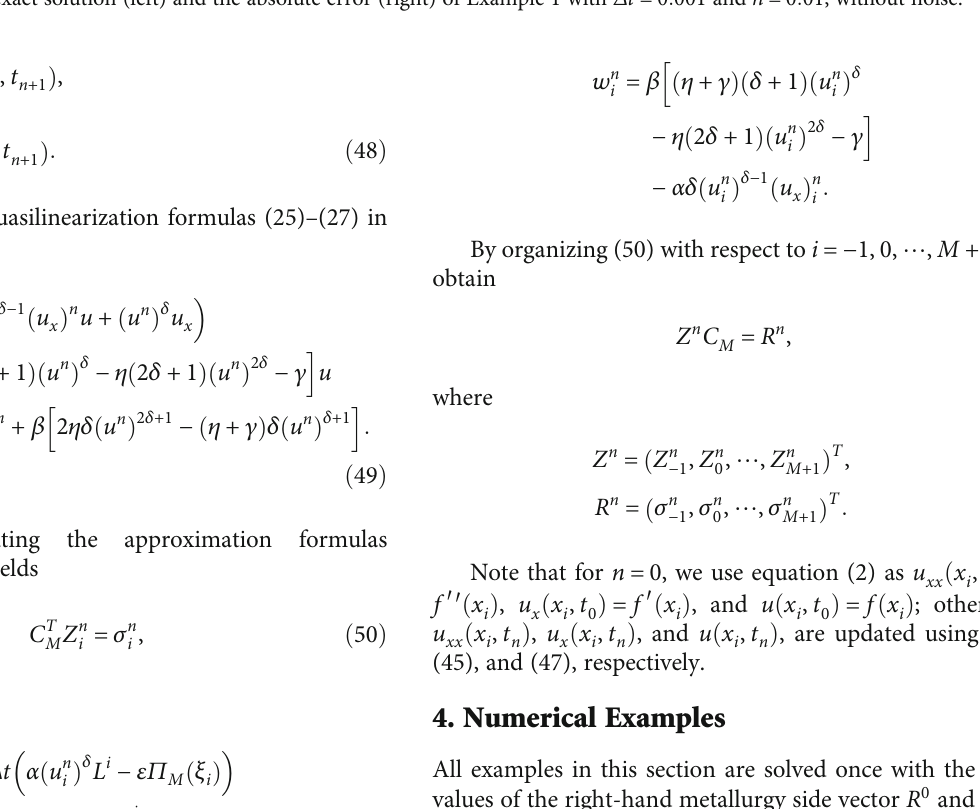
Figure 1: The exact solution (left) and the absolute error (right) of Example 1 with Δ t = 0 : 001 and h = 0 : 01 , without